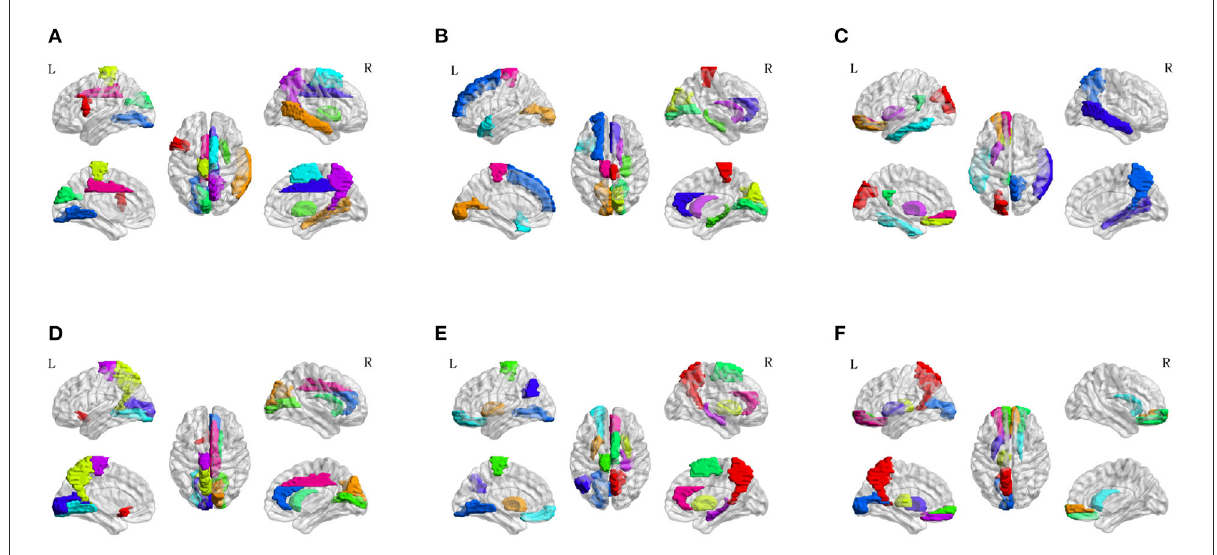
FIGURE7 Spatial visualization of top 10 brain regions in the six classification scenarios. (A) NC vs. SMC. (B) NC vs. EMCI. (C) NC vs. LMCI. (D) SMC vs. EMCI. (E) SMC vs. LMCI. (F) EMCI vs. LMCI.